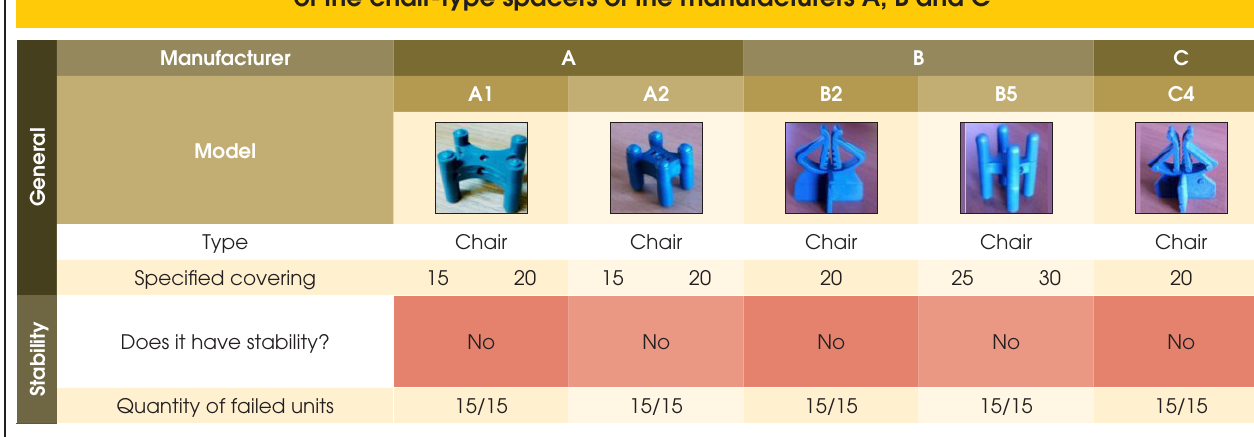
Table 13 – Results of the stability requirement